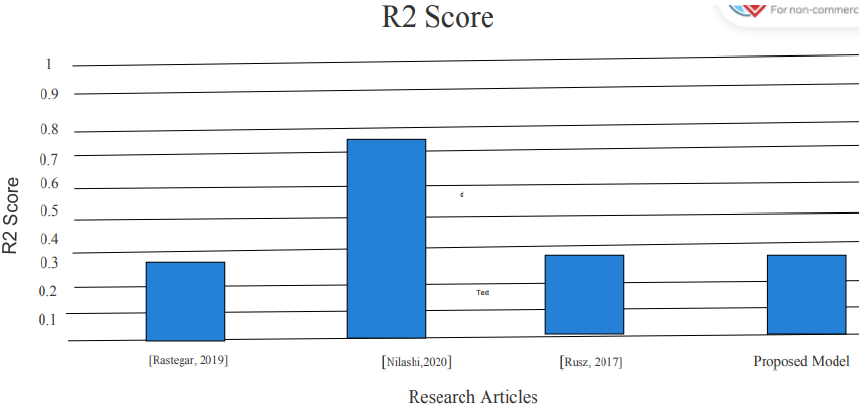
Figure 7. R-squared score comparison